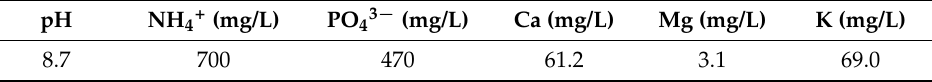
Table 4. Essential nutrient content of the liquid phase of the anaerobic